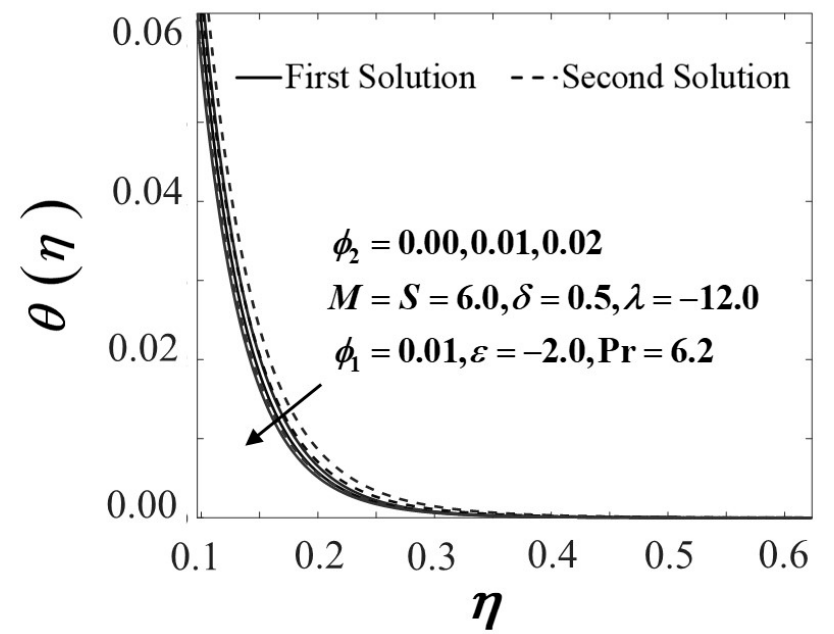
( ) θ η φ when 12.0 λ= − . Figure 5. θ ( η ) with various φ 2 when λ = − Figure 5. with various 2